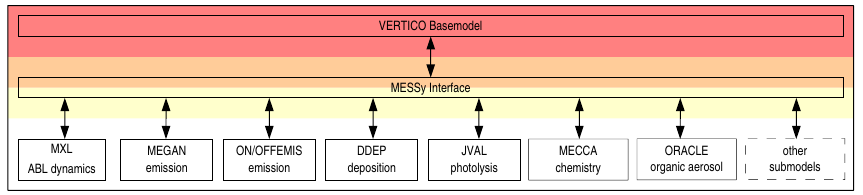
Figure 4. Scheme of the implementation of the VERTICO base model in the MESSy structure and the coupling to the MXL and other submodels through the MESSy interface.